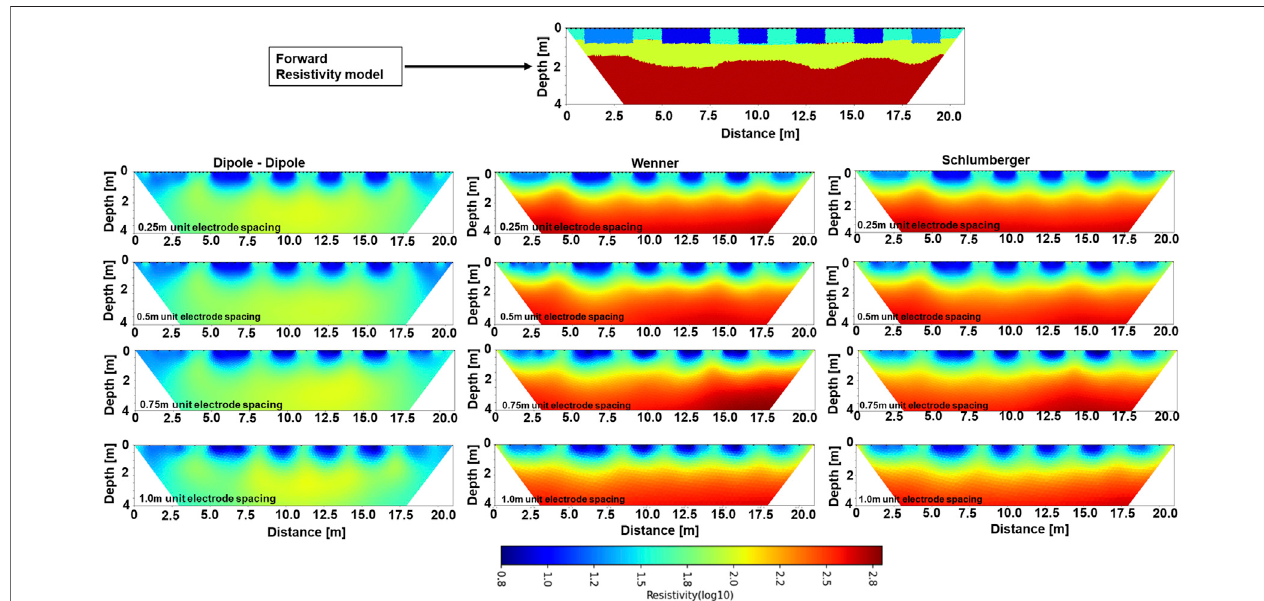
FIGURE 4 | Comparison of results from multiple forward simulation scenarios. Row 1 shows the conceptual model with the resistivity distribution and outline graves. Columns1,2,and3showresultsforsimulationusingdipole – dipole,Wenner,and Schlumbergerelectrodecon fi gurations, respectively,whilerows2,3,4,and5 show simulation using 0.25-, 0.5-, 0.75-, and 1.0-m electrode con fi gurations,